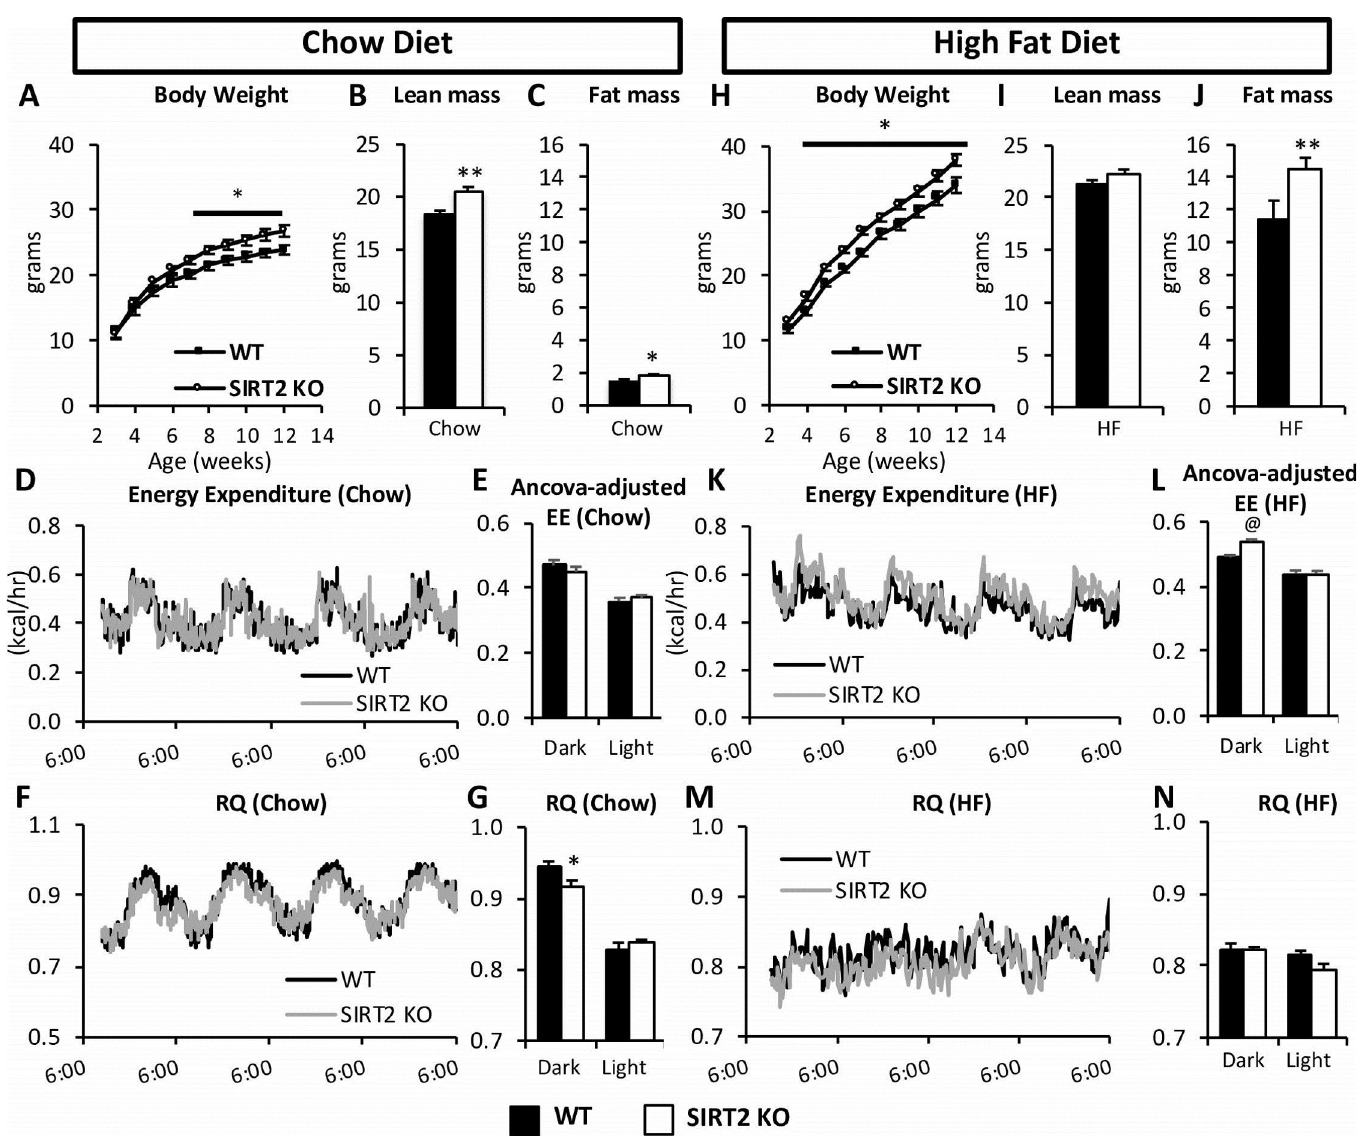
Fig 2. HF SIRT2 KO mice exhibit increased adiposity and energy expenditure. ( A ) Body weight of the chow WT and SIRT2 KO mice. Lean ( B ) and fat mass ( C ) in WT and SIRT2 KO mice on a chow diet at 12 weeks of age. Energy Expenditure (EE) over time ( D ) or ANCOVA-adjusted 12h average of EE ( E ) in chow-fed WT or SIRT2 KO mice. RQ over time ( F ) or expressed as 12h averages ( G ) in chow-fed WT or SIRT2 KO mice. (H) Body weight of the HF-fed WT and SIRT2 KO mice. Lean ( I ) and fat mass ( J ) in WT and SIRT2 KO mice on a HF diet at 12 weeks of age. Energy Expenditure (EE) over time ( K ) or ANCOVA-adjusted 12h average of EE, regressed to body weight ( L ) in HF-fed WT or SIRT2 KO mice. RQ over time ( M ) or expressed as 12h averages ( N ) in HF-fed WT or SIRT2 KO mice. @ p < 0.05 WT vs. SIRT2 KO by ANCOVA when regression is run against body weight, absolute fat mass or absolute fat-free mass. There was no interaction between body weight, lean mass, fat mass, and Energy Expenditure. (n = 8/group for all panels). Black bars: WT; open bars: SIRT2 KO.